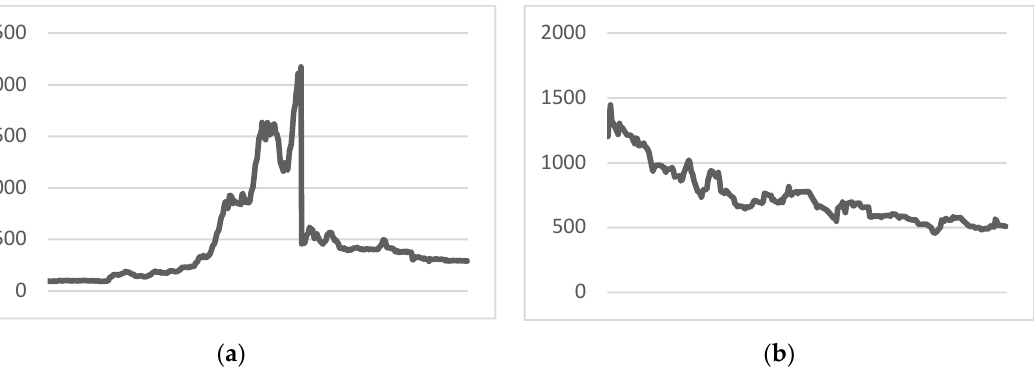
Figure 2. ( a ) Algoquant Fintech Ltd. share price fluctuations from January 2017 to July 2022; ( b ) PB Fintech Ltd. share price fluctuations from November 2021 to July 2022 (BSE 2022).